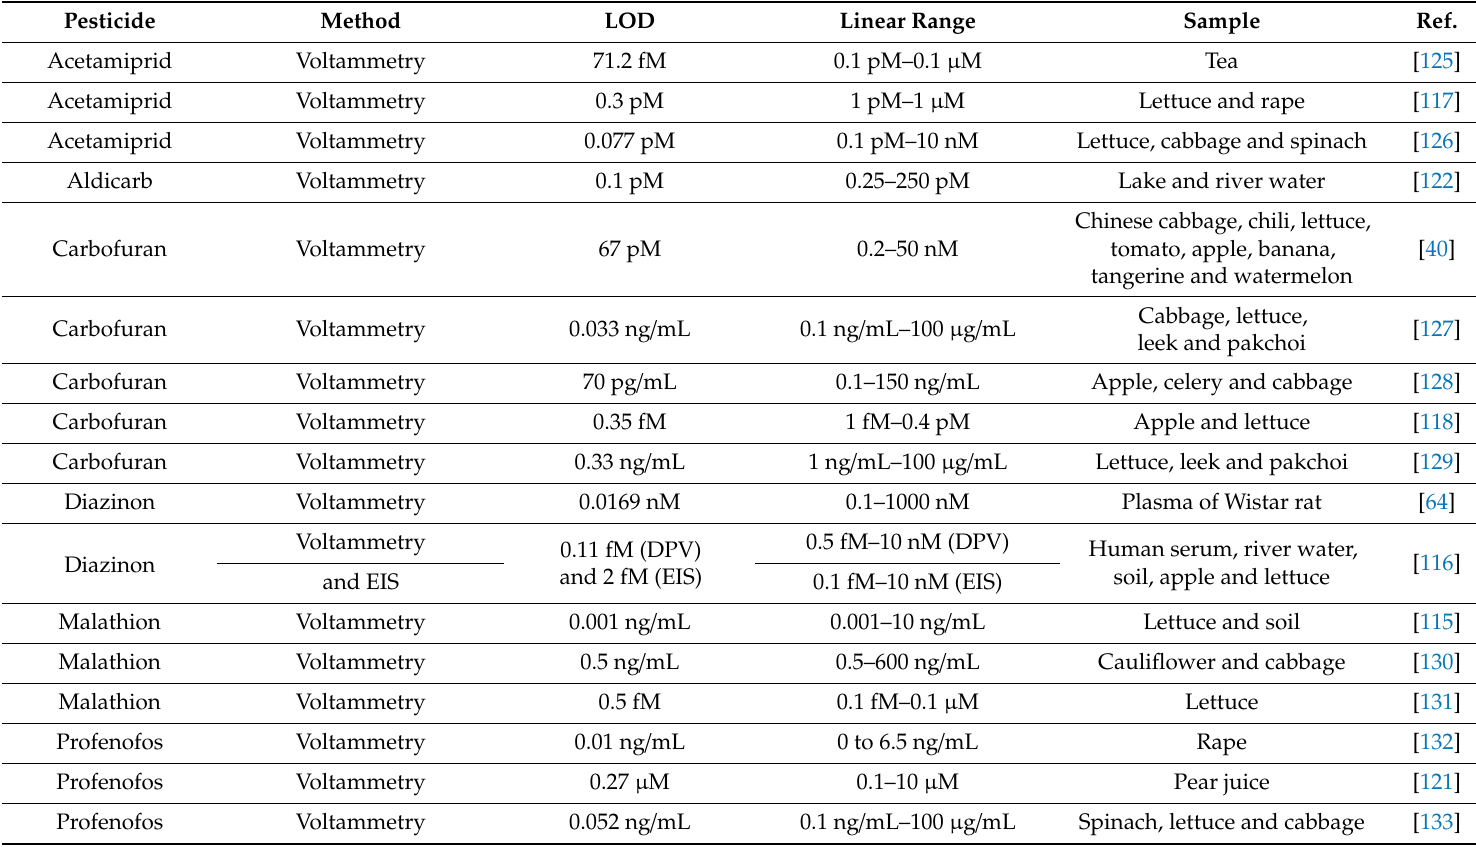
Table 4. Electrochemical aptasensors for pesticide